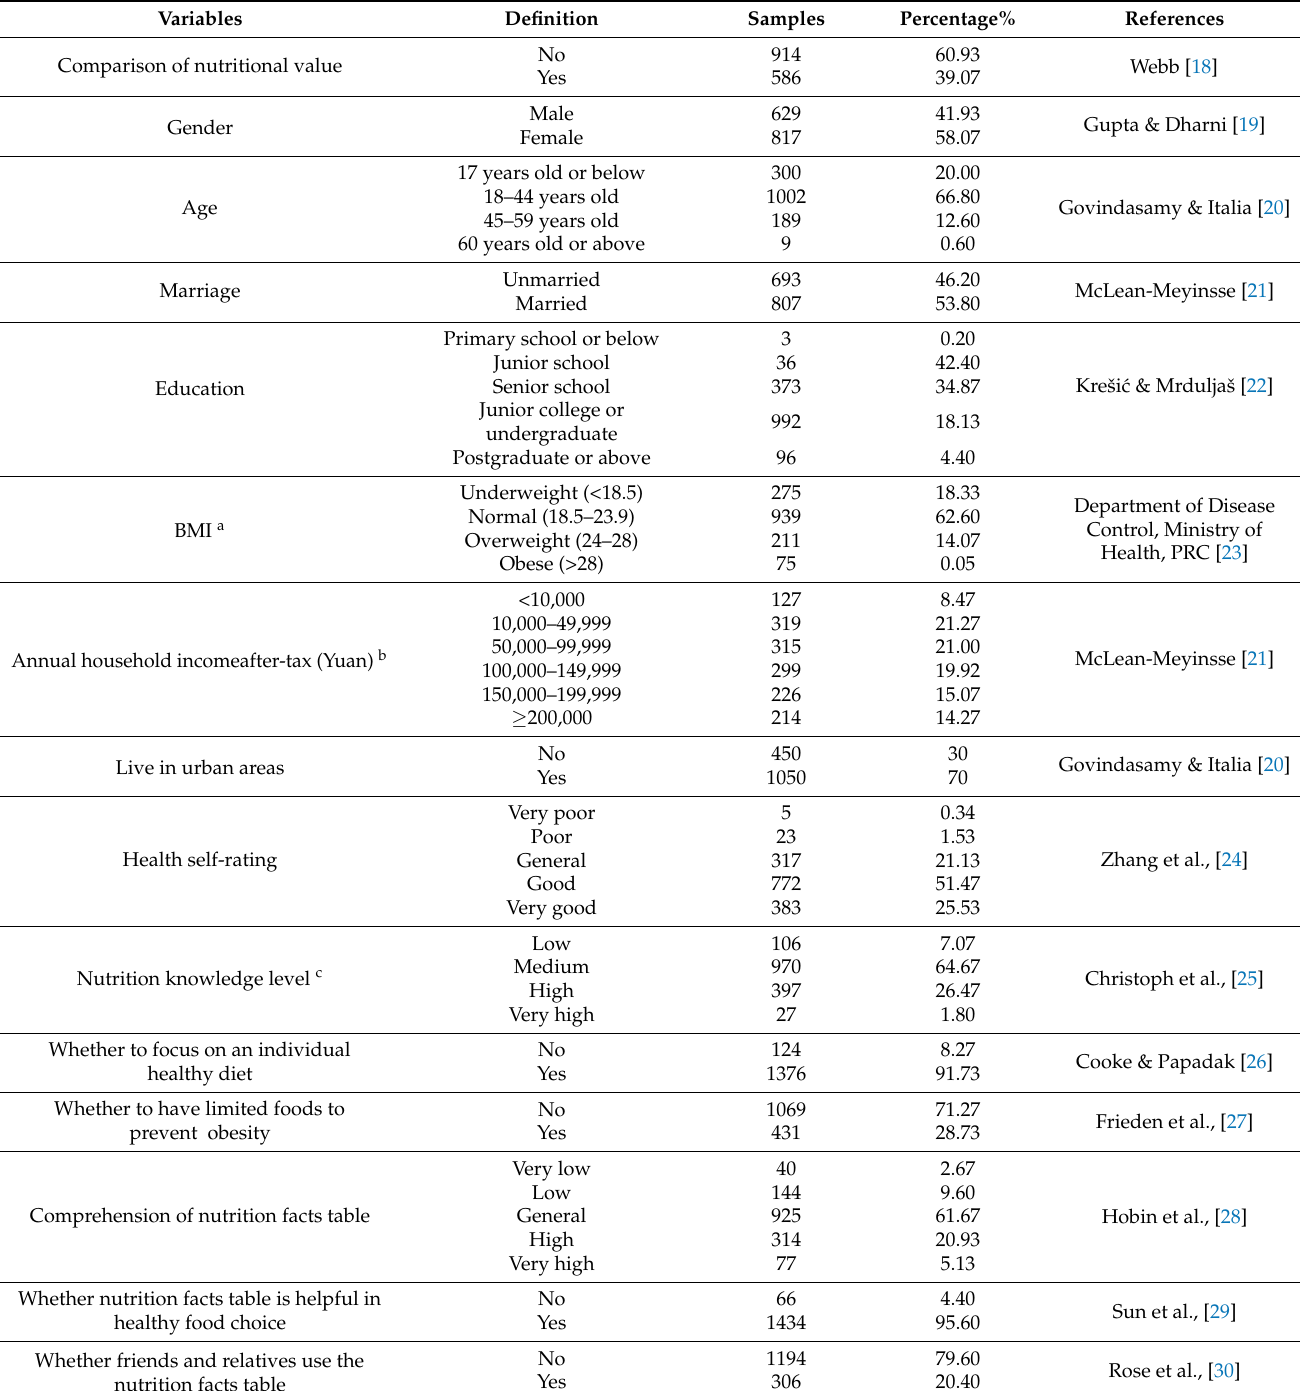
Table 1. Variables initially identified through a literature